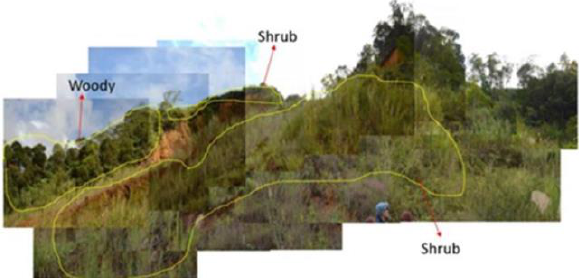
Figure 12. Plot 1 landside multi-photo vertical profiling On the right side of the plot, the terrain of the landslide body is mostly covered by Napier grass/shrub. The soil is spongy and damp, which is suitable for Napier grass to grow (Henderson and Preston, 1977; Orodho, 2006). This plot is classified as an active landslide area with clear evidence of fresh cracks on the terrain. The terrain condition of this area is totally different compared to the right-side area with more stable terrain condition. Figure 13 shows 6 landslide polygon located in Plot 2 of rotational slide.